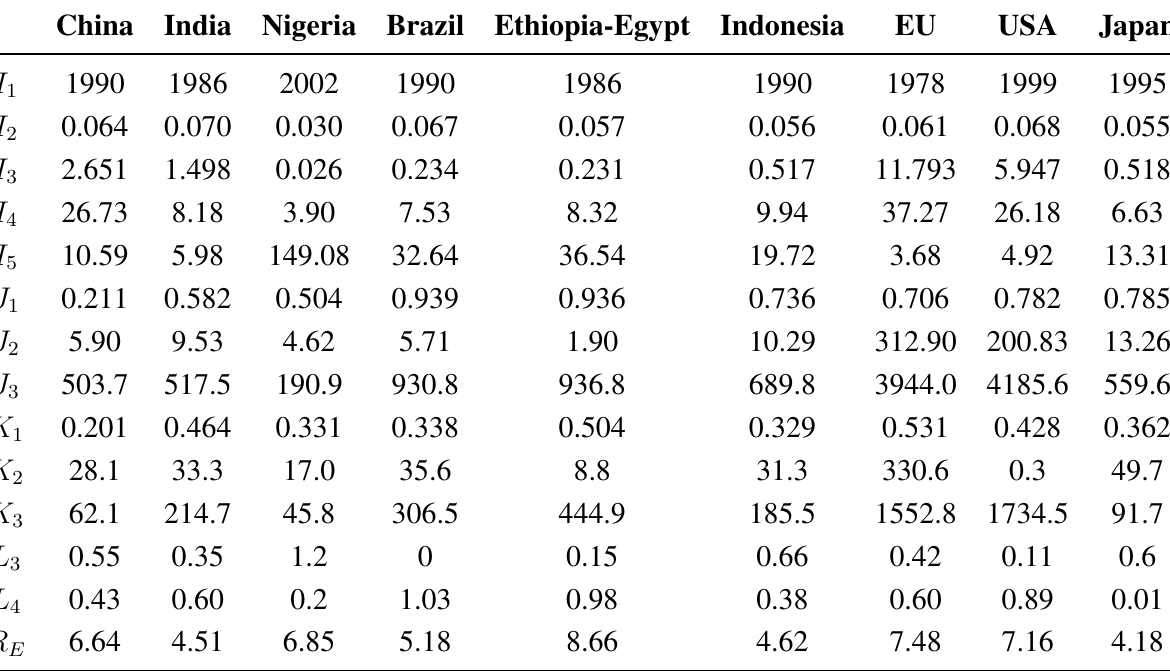
Table 6. Region-dependent constants for experiential learning.